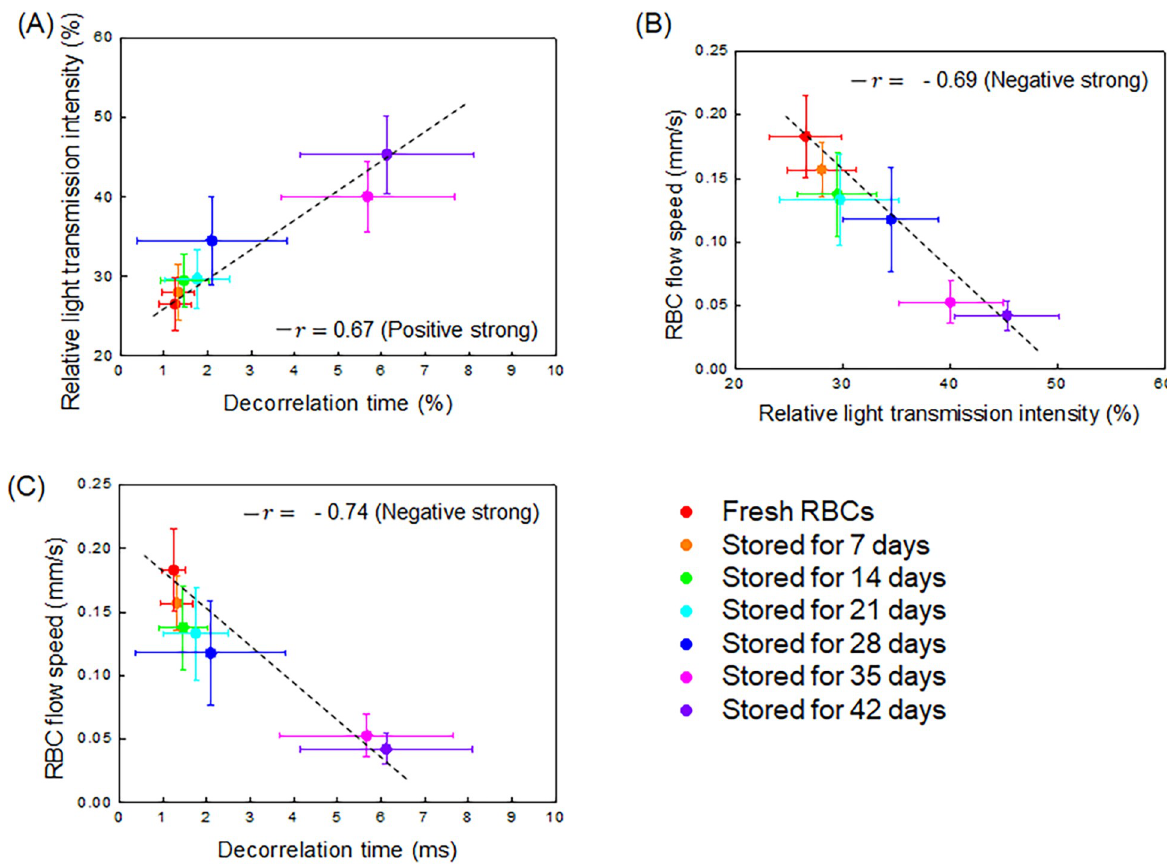
Fig 5. Averaged correlation plots and map among relative light transmission intensity, RBC flow speed, and decorrelation time over the RBC storage duration (n = 13). The relationships between (A) relative light transmission intensity and decorrelation time, (B) RBC flow speed and relative light transmission intensity, (C) RBC flow speed and decorrelation time. The solid line indicates the linear correlation coefficient of the data points. The closer r is to 1 or –1, the more linear the scatterplot of each group’s variables (-1 � r � 1).